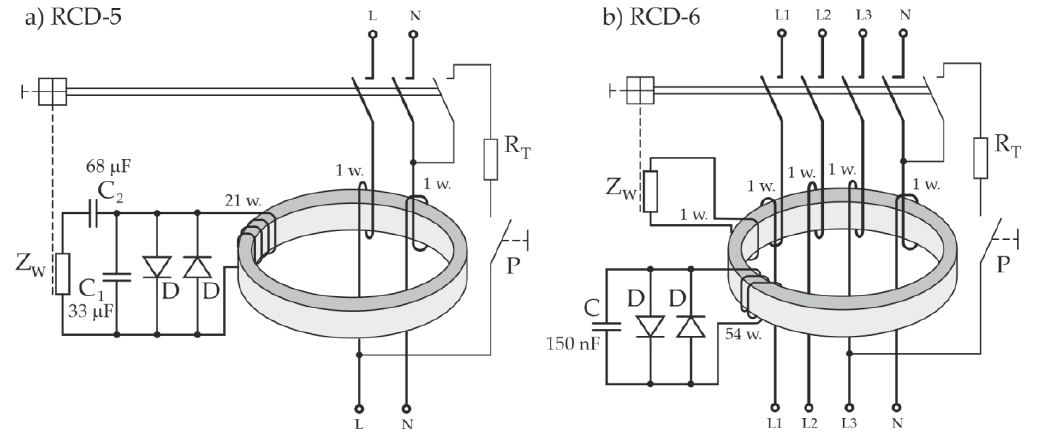
Figure 9. Diagram of the internal structure of the tested circuit breakers: ( a ) RCD-5 and ( b )